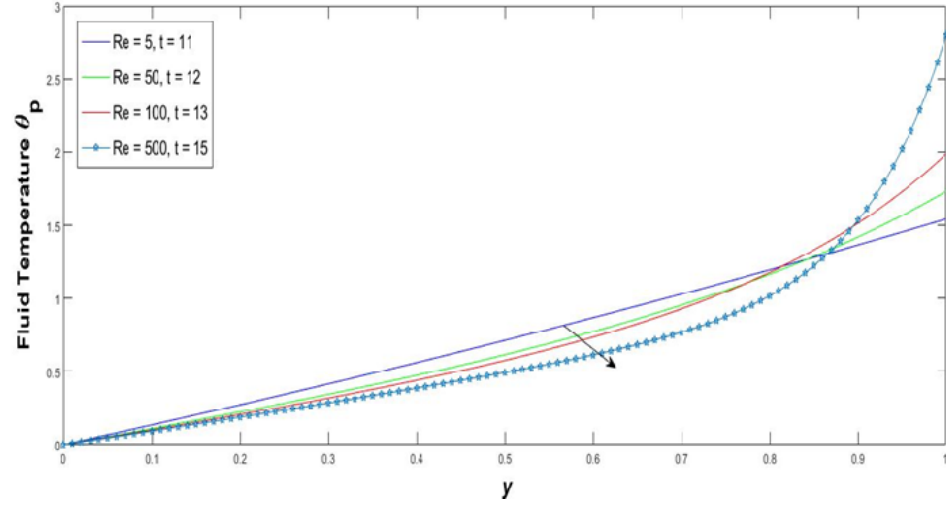
Figure 23. Temperature field for various Reynolds numbers.